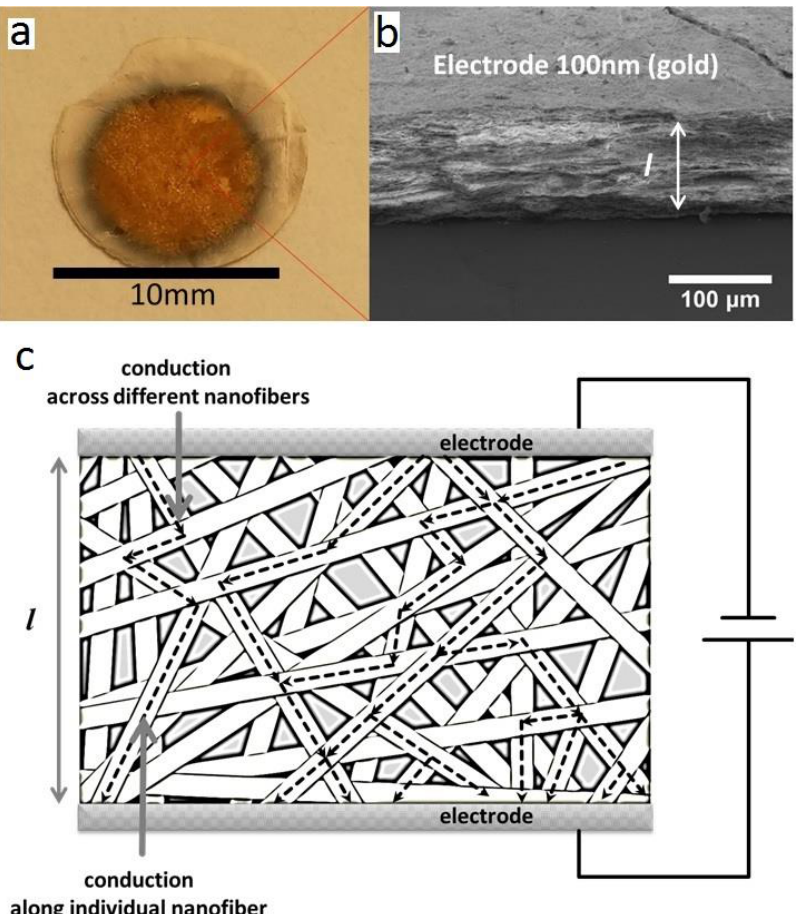
Figure 4. ( a ) Digital photo of a symmetric CGO600 nanofibrous cell; ( b ) SEM micrograph of the same cell; the thickness (ca. 100 μm) and the gold electrodes are indicated; ( c ) scheme of the symmetric CGO cell showing the ionic conduction pathway along the individual nanofibers (bulk component) and across different nanofibers (interface component).